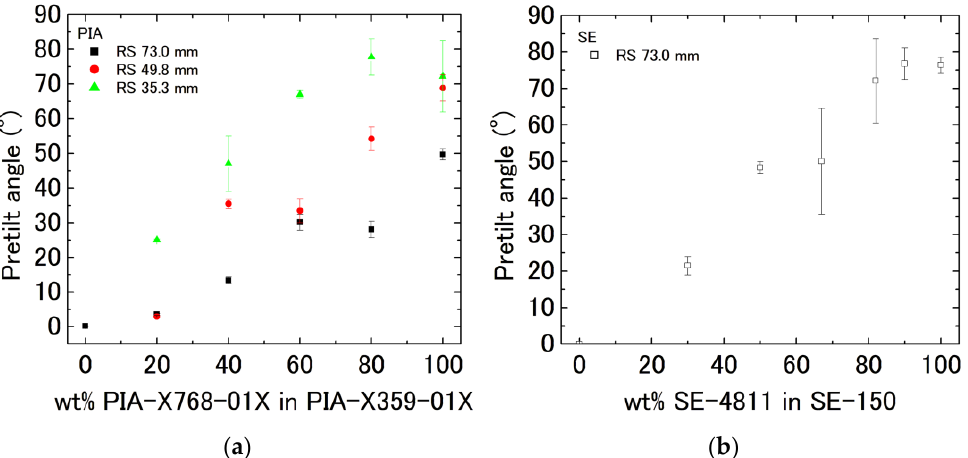
Figure 5. Average and standard deviation of pretilt angle within mapping range for ( a ) PIA-X768-01X and PIA-X359-01X and ( b ) SE-4811 and SE-150.